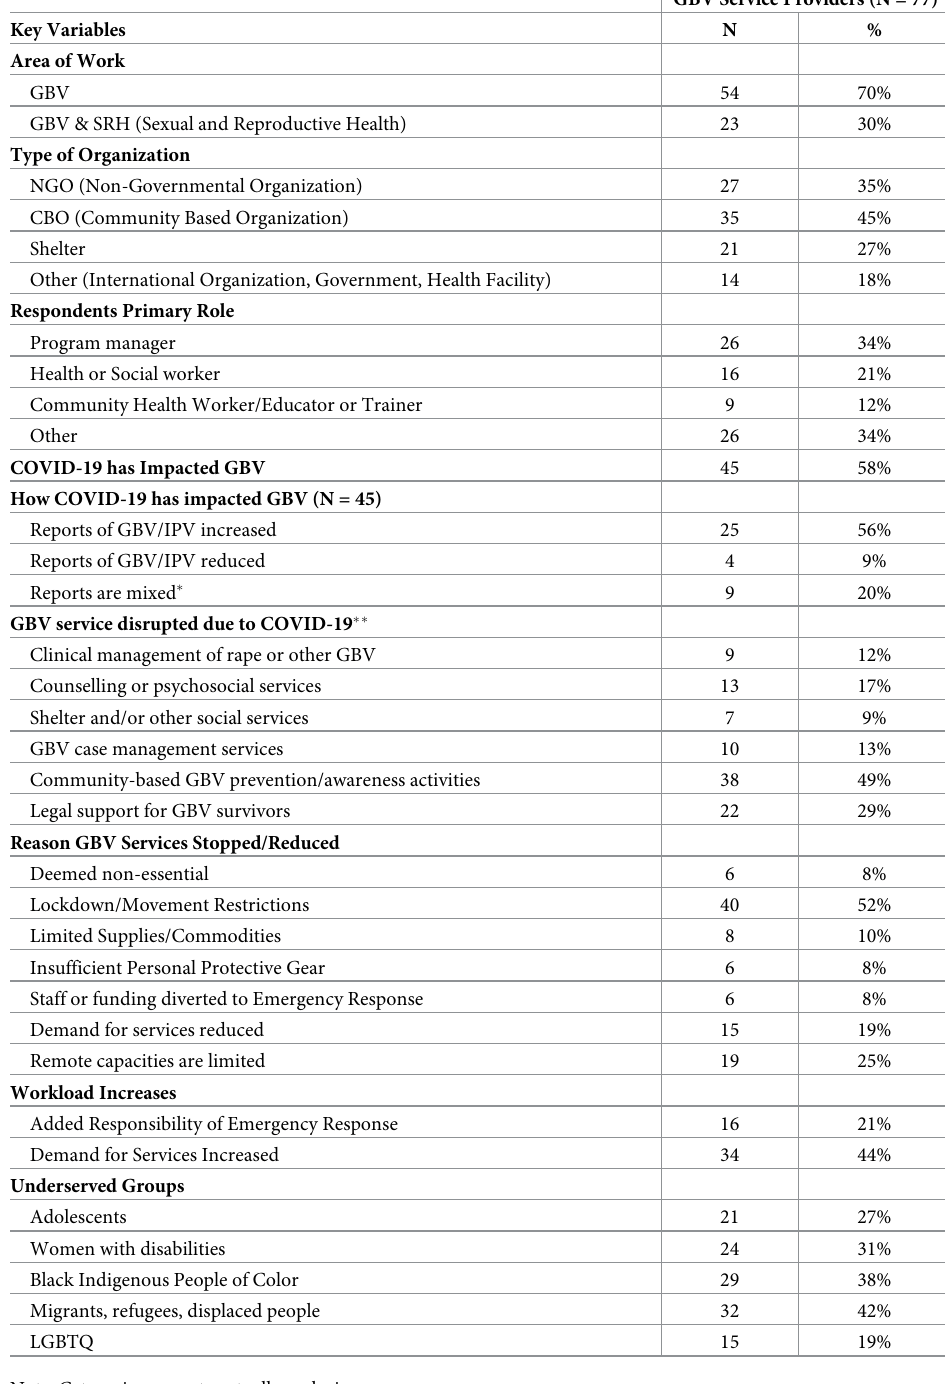
Table 1. Descriptive characteristics, 2020 US GBV service providers survey (N =